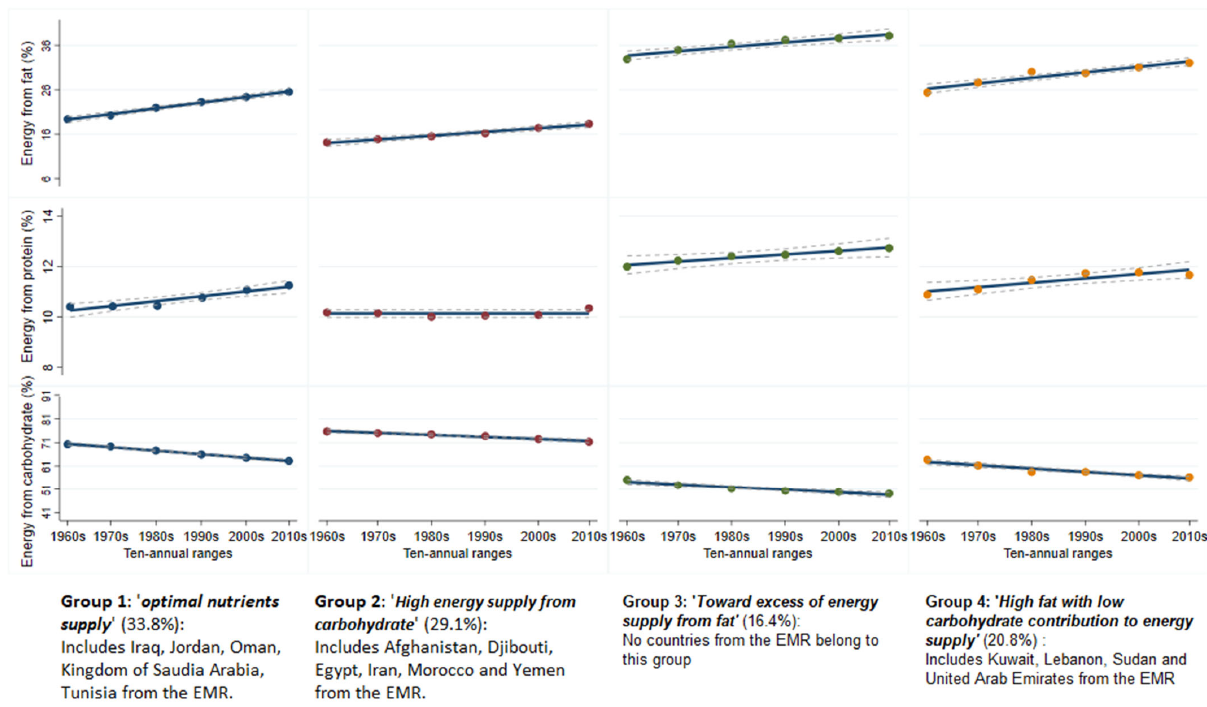
Figure 6. Countries’ profile of dietary energy supply from macro-nutrients (1961 to 2018). Figure caption: Dashed lines refer to 95% confidence interval. X -axis label: 1960s refers to 1961 to 1969; 1970s refers to 1971–1979; 1980s refers to 1980–1989; 1990s refers to 1990–1999; 2000s refers to 2001–2009; 2010s refers to 2010–2018.